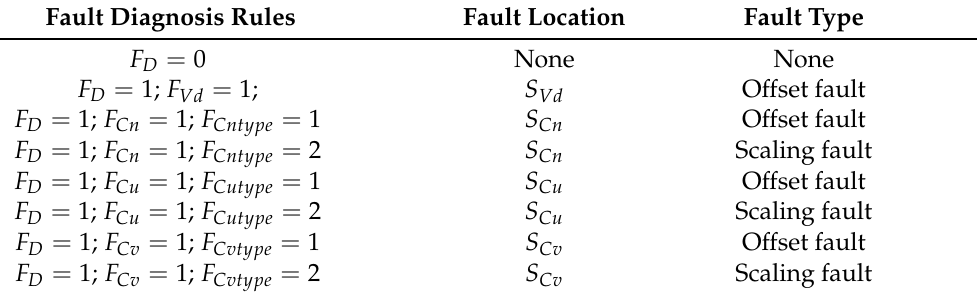
Table 1. Fault diagnosis rules.